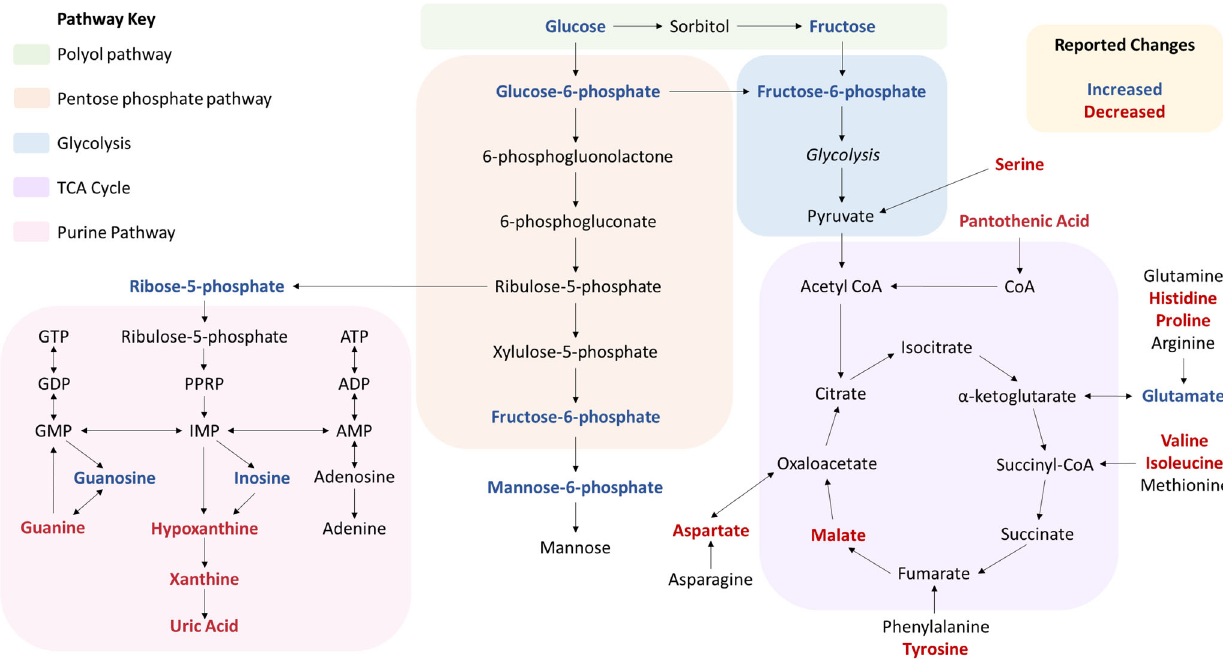
Fig. 6 Pathway changes in the PDD brain. The fi gure indicates changes found in at least one investigated PDD brain region. ADP adenosine diphosphate, AMP adenosine monophosphate, ATP adenosine triphosphate, GMP guanosine monophosphate, GTP guanosine triphosphate, IMP inosinic acid, PPRP phosphoribosyl